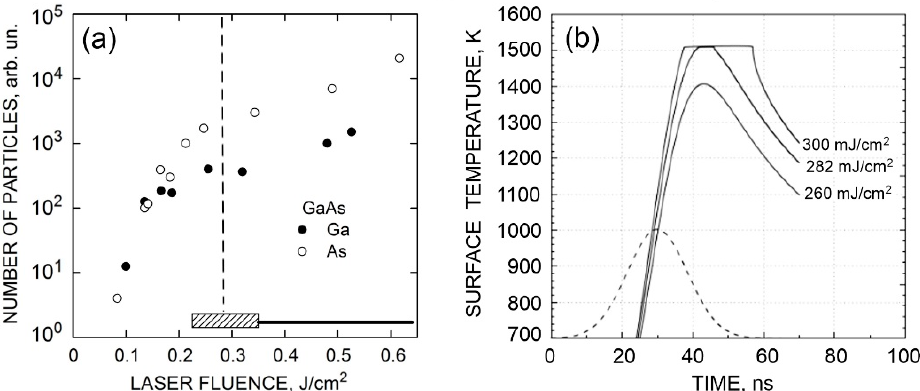
Figure 3. ( a ) The number of Ga and As atoms emitted from the GaAs surface irradiated by 694-nm, 20-ns laser pulses as a function of laser fluence as derived from mass spectrometric measurements (adapted with permission from Ref. [13]). Transient uneven and developed manifestations of in- creased reflectivity indicating the appearance of the liquid phase are marked by the shaded region and the solid line, respectively. Our simulated melting threshold is shown by a vertical dashed line. ( b ) The simulated dynamics of the surface temperature with the identified melting threshold of 282 mJ/cm 2 . The laser pulse profile is shown by the dashed line.